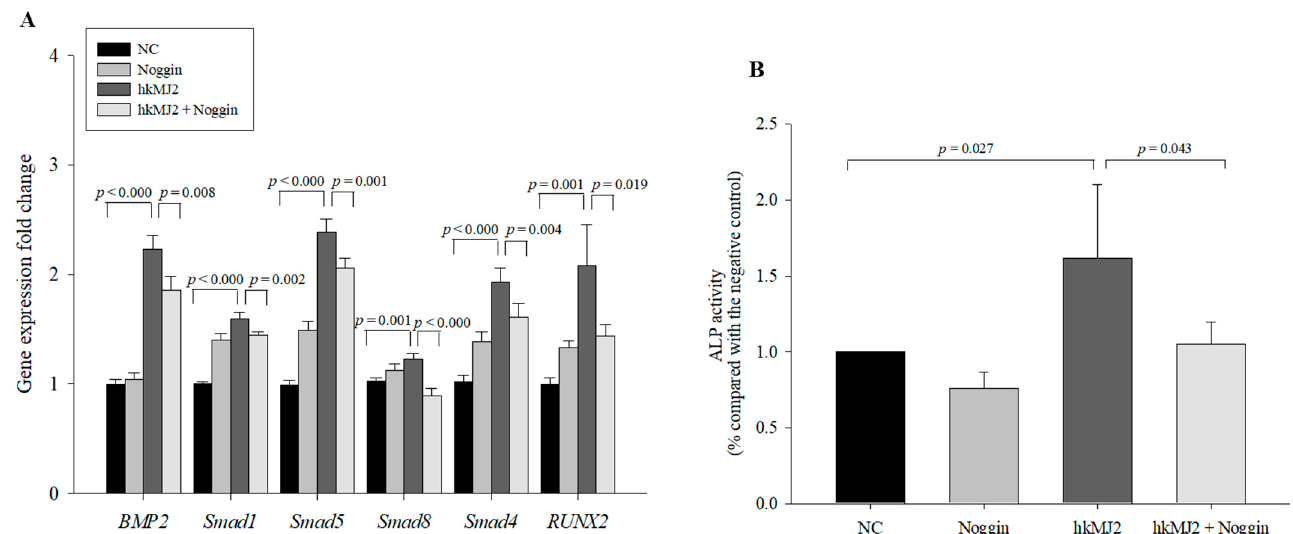
Figure 6. Expression levels of BMP2/RUNX2 signaling-related genes in cells treated with heat-killed P. freudenreichii MJ2 (hkMJ2) (1 × 10 8 cells/mL) and BMP inhibitor Noggin (100 ng/mL) ( A ) and ALP activity ( B ). The values indicate the mean ± SD of three independent experiments performed in triplicate.